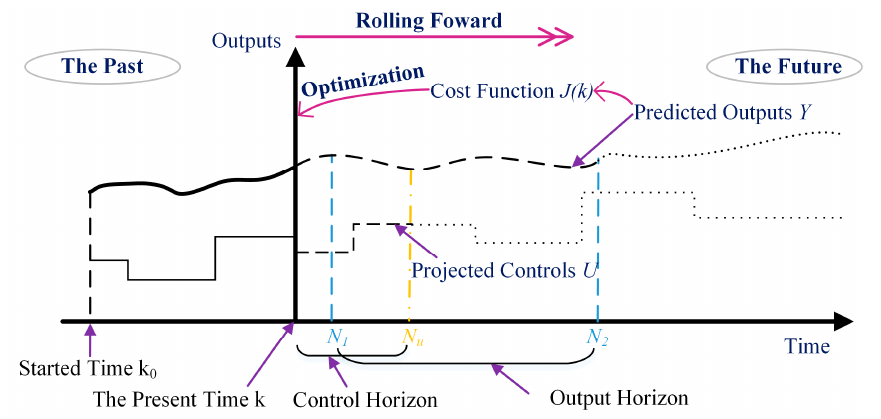
Figure 4. Schematic of generalized predictive control (GPC).